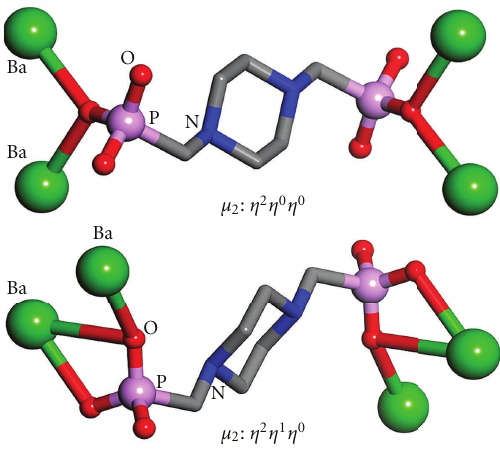
S 1: e coordination modes of the ligand L